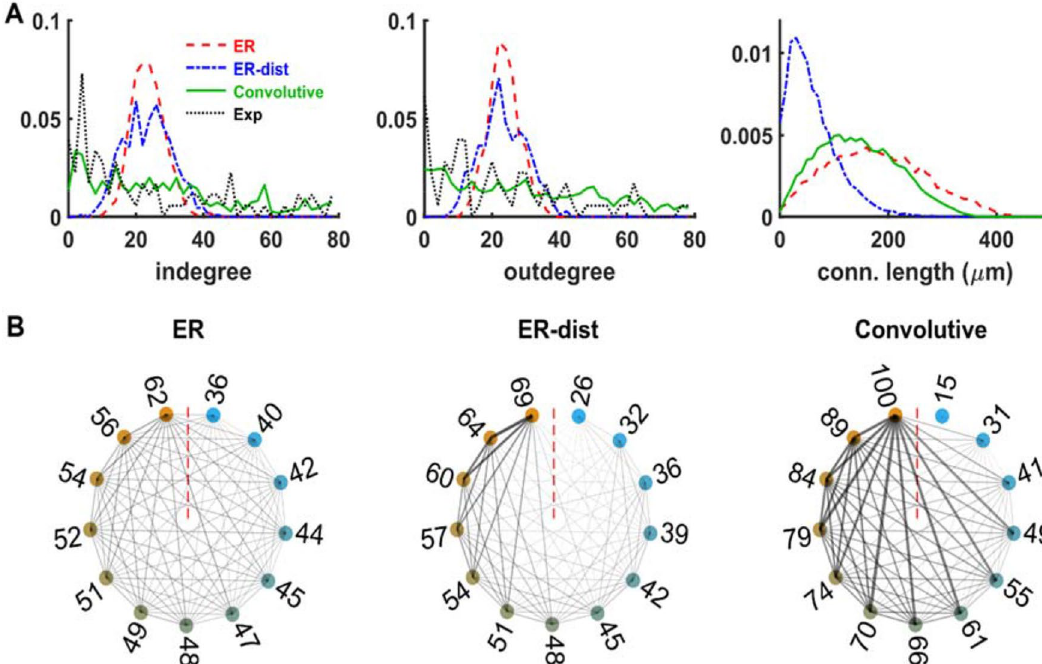
Figure 3. Neurons distributed in a thin rectangular volume. ( A ) In-degree distribution (left), out-degree distribution (middle) and connection length distribution (right) for networks of Epileptors connected as an ER model (red), ER with distance (blue), and using a convolutive model (green), connected as observed in an experimental hippocampal slice (black 23 ), implemented with four blocks and two sub-blocks containing 1% and 99% of the neurons, respectively, and with parameters δ = 0.25, Ek = 0.1 and η = 3. ( B ) Circular graph representation of connectivity for the ER model (left), the ER-dist model (middle) and Convolutive model (right). See the main text for an explanation of how they were constructed. The lines thickness and transparency are proportional to the number of connections between any two given